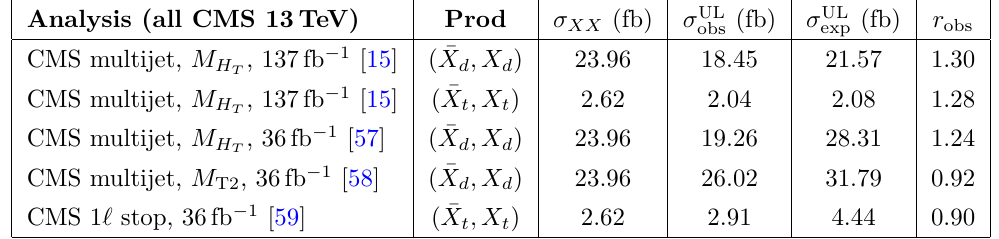
Table 4 . List of the most constraining results for the highest score proto-model. The second column displays the constrained production mode, while the third column shows the respective cross section value. We also show the corresponding observed and expected upper limits and the ratio r = σ UL obs XX /σ obs